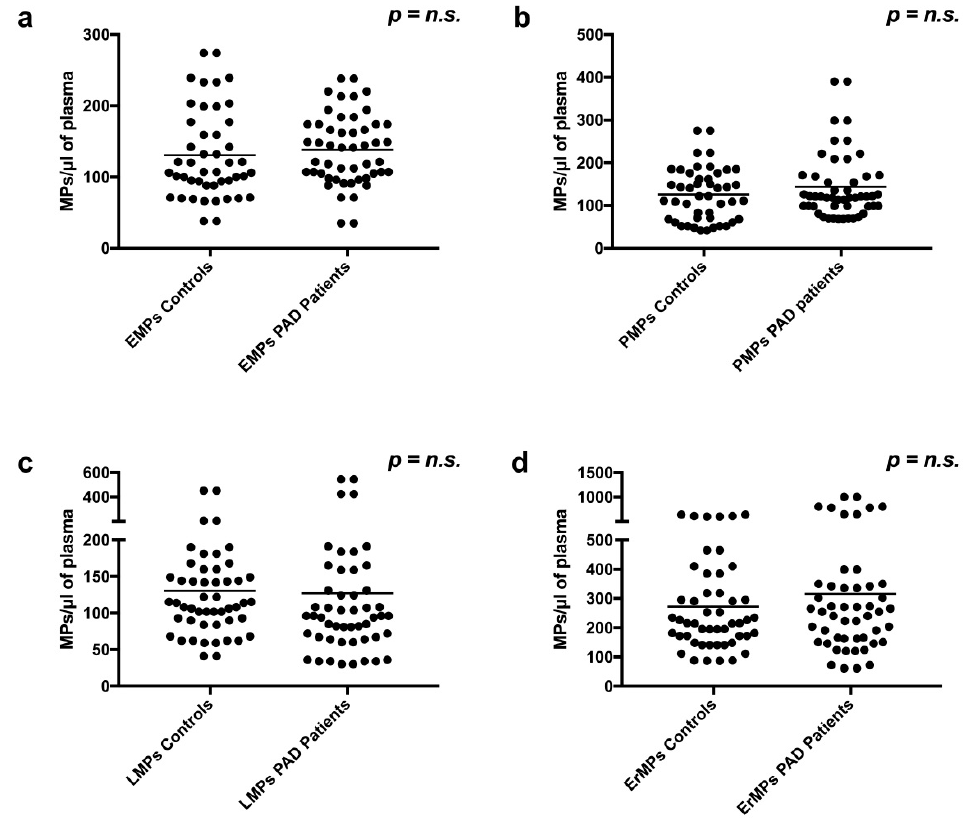
Figure 1. Global number of endothelial microparticles (EMPs) ( a ), platelet-derived microparticles (PMPs) ( b ), leucocyte-derived microparticles (LMPs) ( c ), and erythrocyte-derived microparticles (ErMPs) ( d ) in plasma of peripheral artery disease (PAD) patients and controls. p : p -value; n.s .: not significant. Black horizontal lines in panels indicate median values.